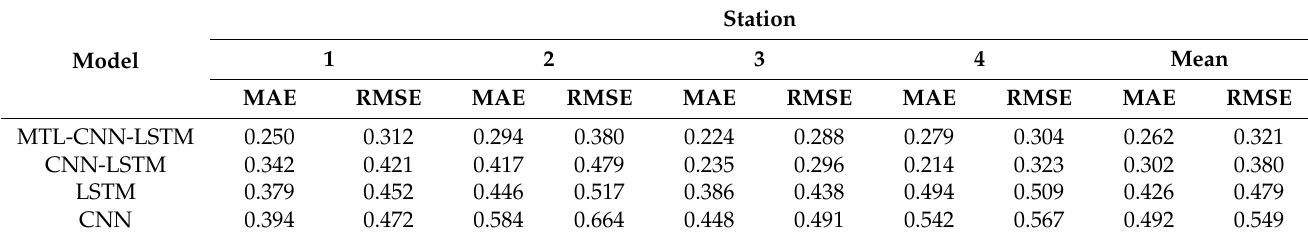
Table 4. Prediction performance evaluation index of different models at t +